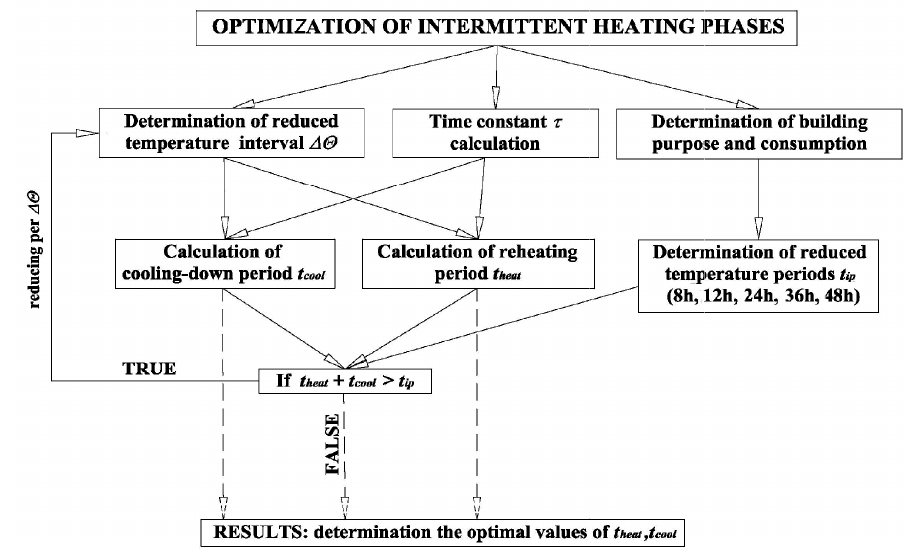
Fig. 9. Optimization algorithm of intermittent heating